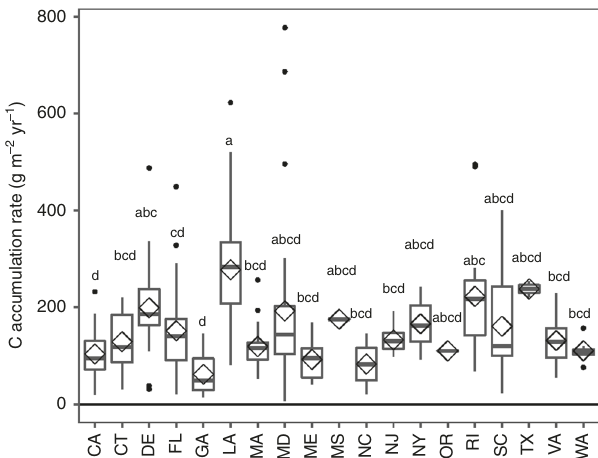
Fig. 4 The boxplot of state level tidal wetlands C accumulation rates in the conterminous United States. Diamond is the mean value, the box is interquartile range, error bar is the largest and smallest value within 1.5 times interquartile range above 75% and below 25%, respectively. Black points indicate outside values. The different lower letters above each bar indicated signi fi cantly difference among states (Tukey HSD).